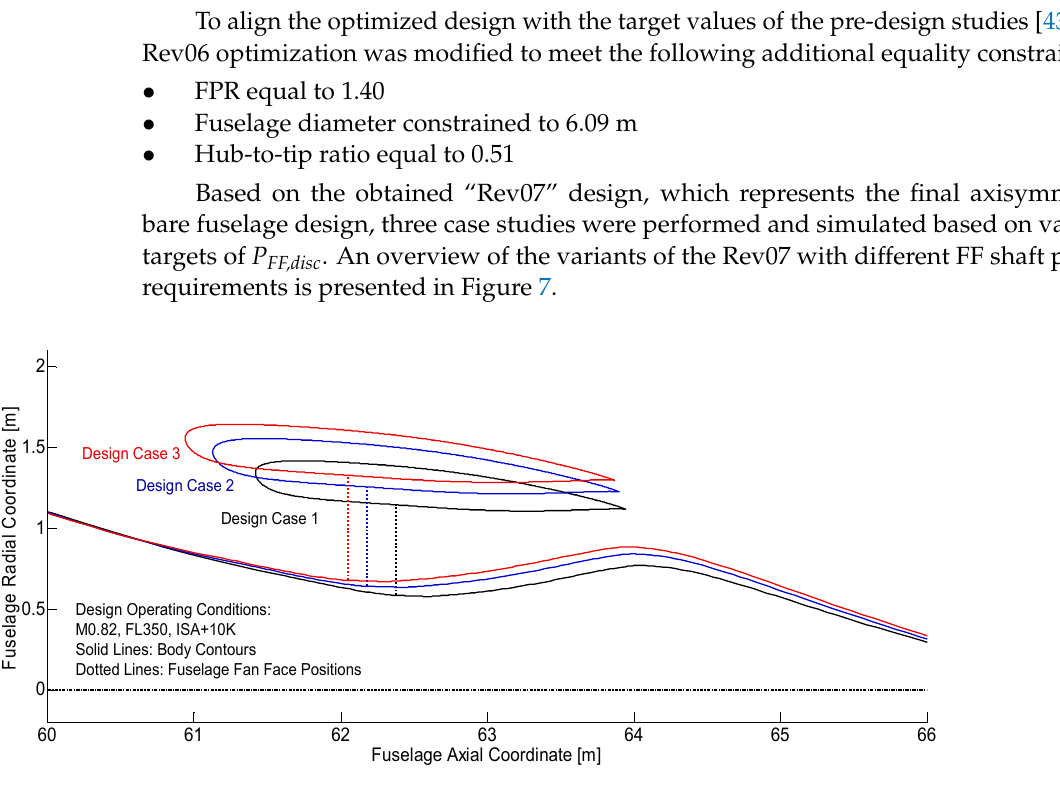
Figure 7. Changes in FF geometry of the Rev07 PFC design for different target FF shaft power. An overview of the corresponding aerodynamic performance for each Rev07 design case study is presented in Table 2. Table 2. Overview of the main aerodynamic performance parameters for three different case stud- ies based on the Rev07 axisymmetric bare PFC design Parameter